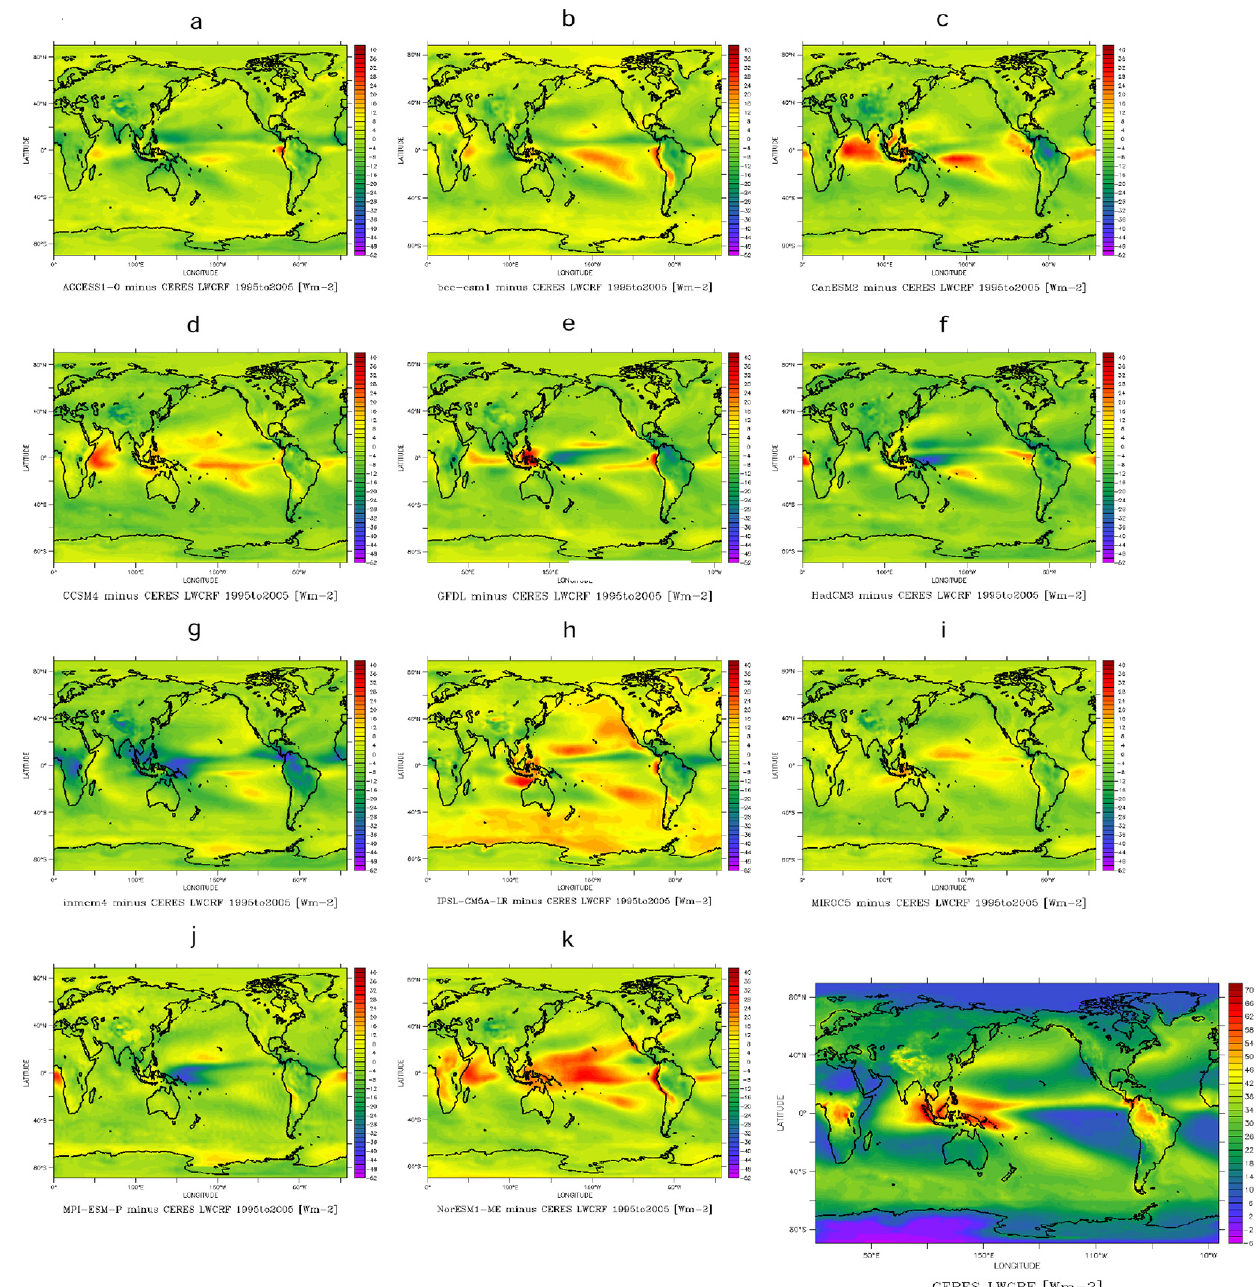
Figure 2. Long-wave cloud radiative forcing (LWCRF) for CERES and several CMIP5 models. Panels (a) to (k) show map plots for the specific CMIP5 models minus CERES data. In the lowermost right corner is the CERES LWCRF plot. All plots are given in Wm − 2 representing a 10-year mean. The color bar for the CERES LWCRF plot: − 6 up to 70Wm − 2 and for the difference plots: − 52 up to 42Wm − 2